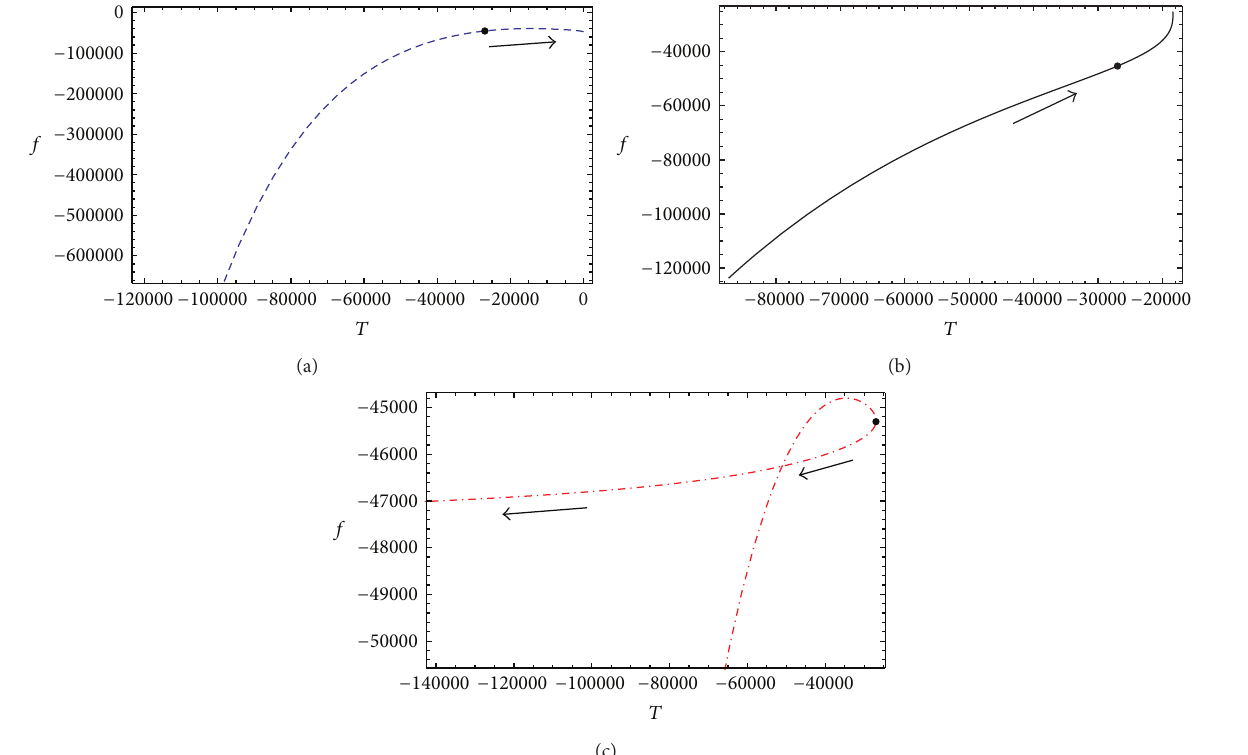
Figure 4: Future evolution of 𝑓(𝑇) for (a) 𝜔 𝜗 = −0.5 , (b) 𝜔 𝜗 = −1 , and (c) 𝜔 𝜗 = −1.5 with −1 ⩽ 𝑧 ⩽ 1 . The dot denotes the present day value of the function 𝑓(𝑇) .